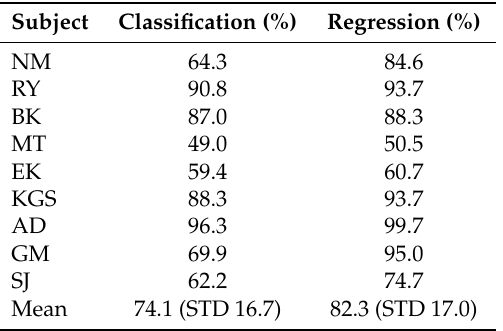
Table 4. Subject-wise balanced accuracy using user-independent model and a combination of BVP and ST